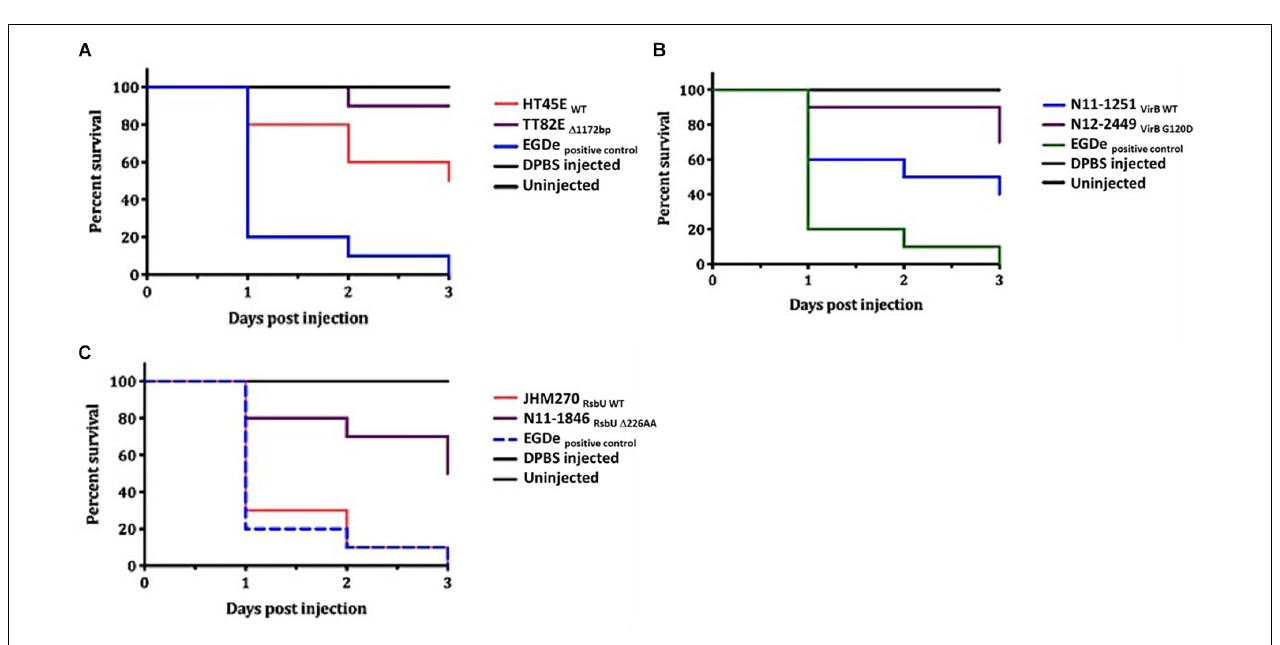
FIGURE 13 | Virulence evaluation of high nisin sensitivity L. monocytogenes field strains harboring dltA , virB, and rsbU mutations using the zebrafish embryo-based infection model. Kaplan-Meier plots depicting the survivals trends of zebrafish embryos infected with strains (A) TT82E (deletion of entire dlt operon promoter and the first 67 N-terminus amino acids in DltA), (B) N12-2449 (VirB G120D ) and (C) N11-1846 (RsbU D226 ) compared to corresponding control strains from same MLST CCs but without mutations (A) HT45E, (B) N11-1251, JHM270. Data presented is based on three independent biological experiments. Survival curves and trends were significantly higher in zebrafish embryos infected with the high nisin sensitivity strains dltA , virB and rsbU mutations compared to un mutated respective clonal control strains at 24, 48, and 72 hpi ( p < 0.05).